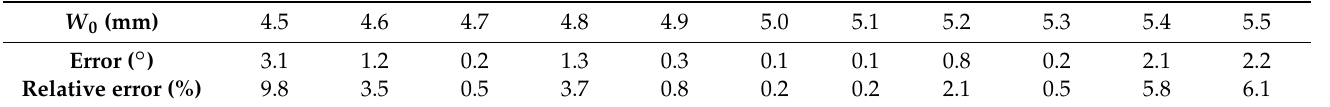
Table 12. Comparison between model calculation and HFSS simulation results when parameters of W 0 change.